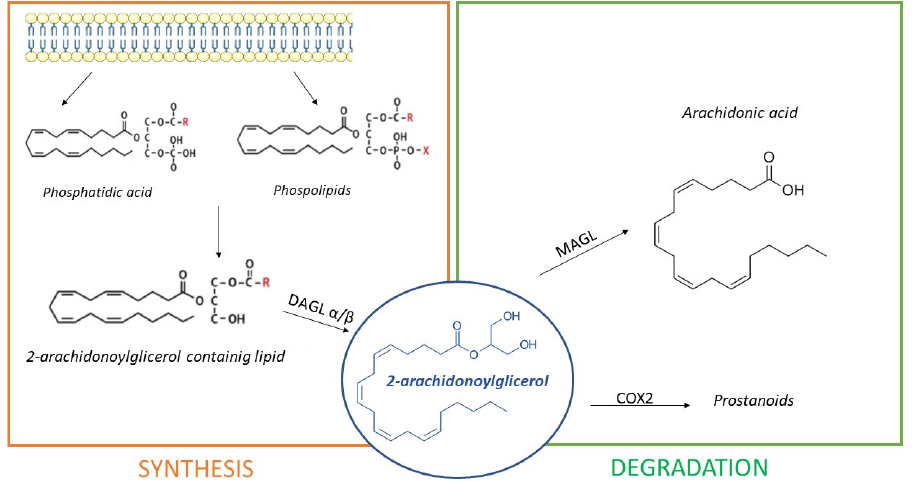
Figure 3. The synthesis of 2-Arachidonoylglicerol (2-AG). Synthesis happens because of diacylglycerol lipase (DAGL) α / β , from phosphatidic acids and phospholipids proceeding from the cell membrane. Additionally, 2-AG is degraded by monoacylglycerol lipase (MAGL) in arachidonic acid and by cyclooxygenase-2 (COX2) in prostanoids.